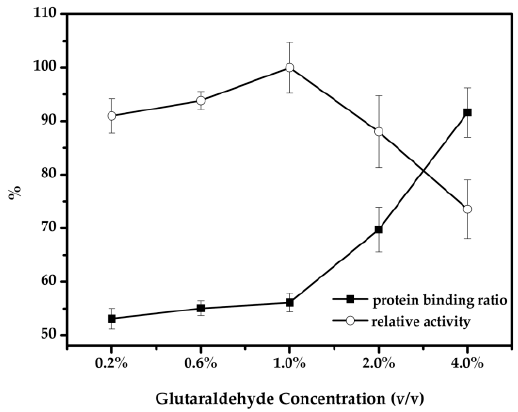
Figure 4. Effect of the glutaraldehyde concentration on the activity of immobilized cellulose.